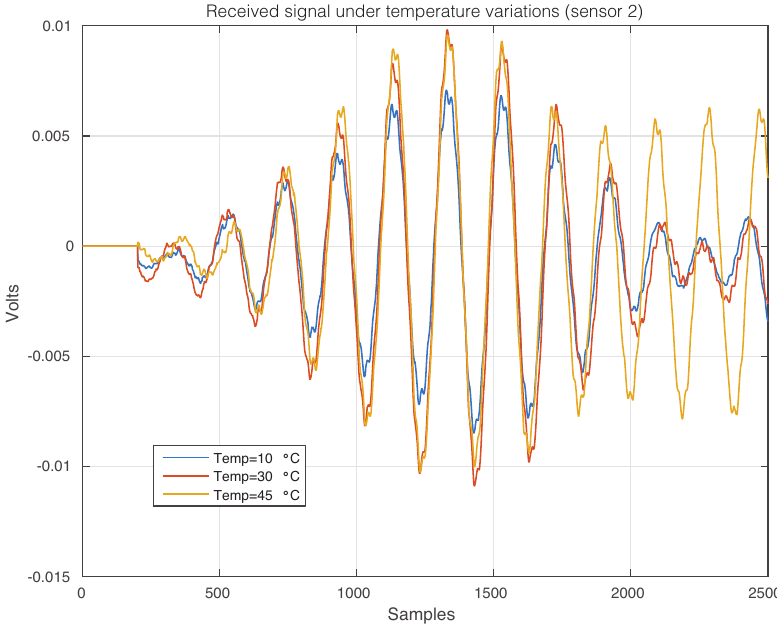
Figure 11. Signal that is received by Sensor 2 when the first sensor is used as an actuator.